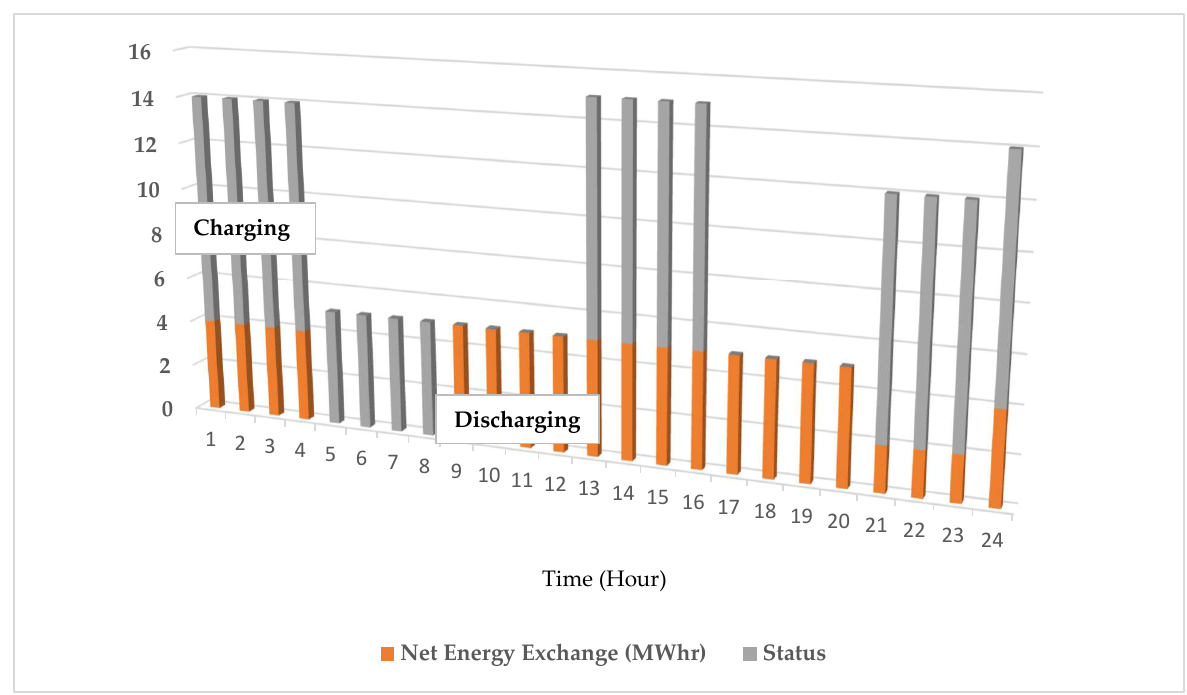
Figure 6. ESS commitment towards modernized energy exchange over a single day.